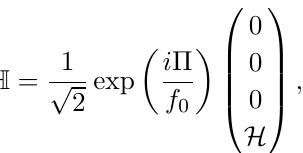
Figure 1 . An illustration of a benchmark pro- cess of 0 ++ twin glueball ^ G heavy twin Higgs ^ h at the LHC and decays to the SM bottom quarks through an o(cid:11)-shell SM